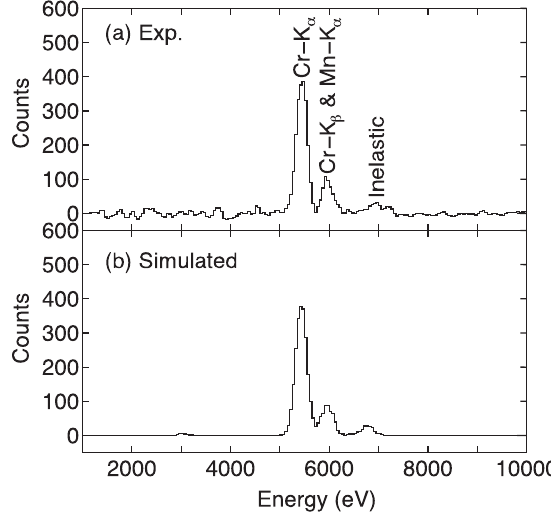
FIG. 29. X-ray spectra (a) measured with HP Ge detectors and (b) simulated with the EGS5 Monte Carlo computer